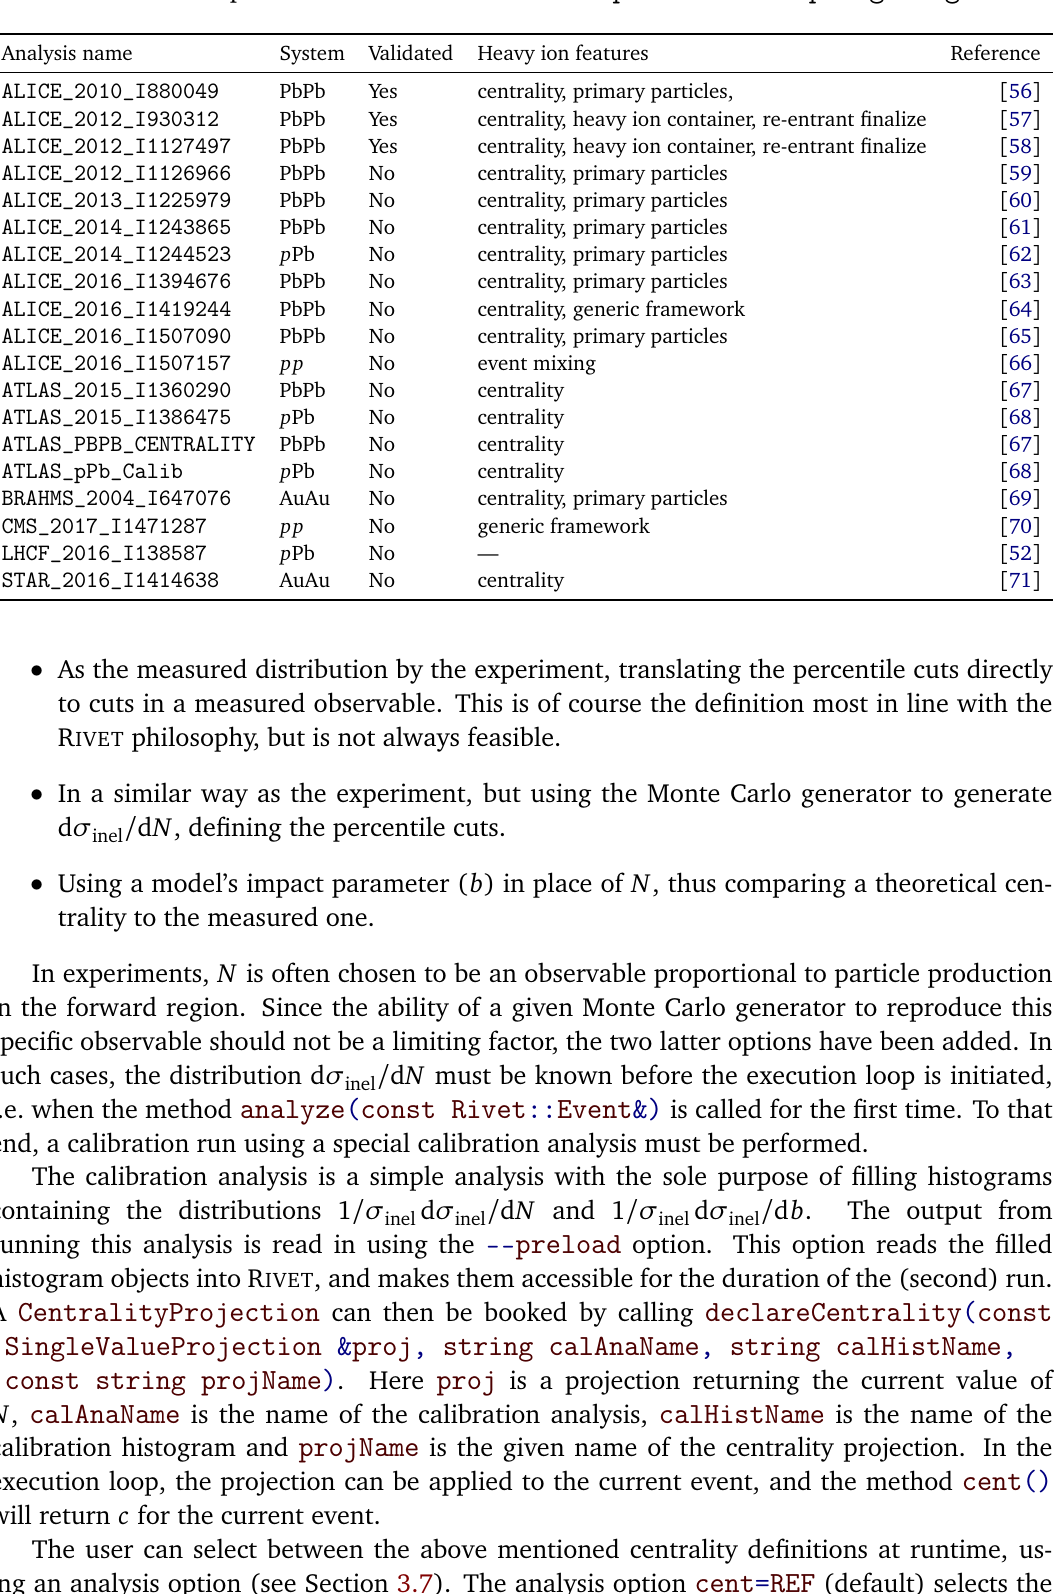
Table 1: All R IVET analyses implementing one or more heavy ion features, or heavy ion beams. An up-to-date list can be found at https://rivet.hepforge.org